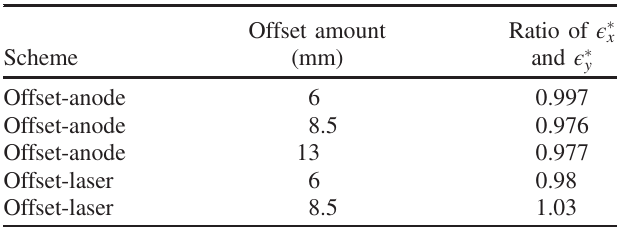
TABLE III. Ratios of normalized x and y emittances for all offset anode and laser cases.